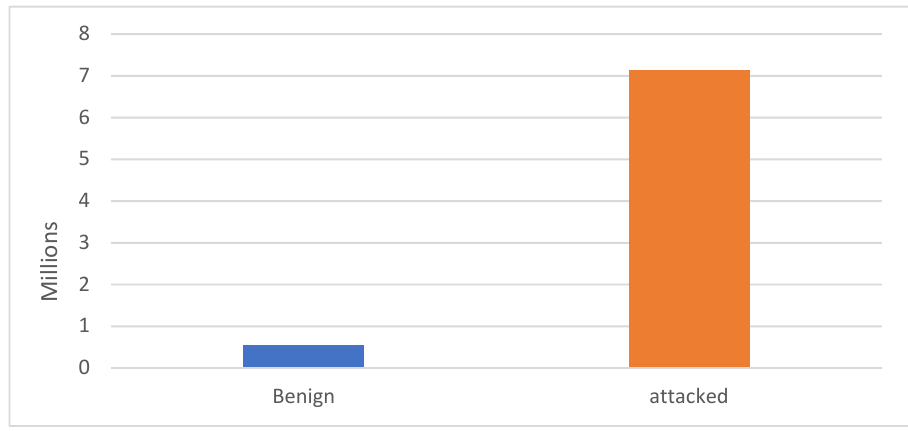
Figure 2. The distribution of attack and benign classes’ instances. Table 6. Number of samples for normal and attack classes in the training and testing dataset.